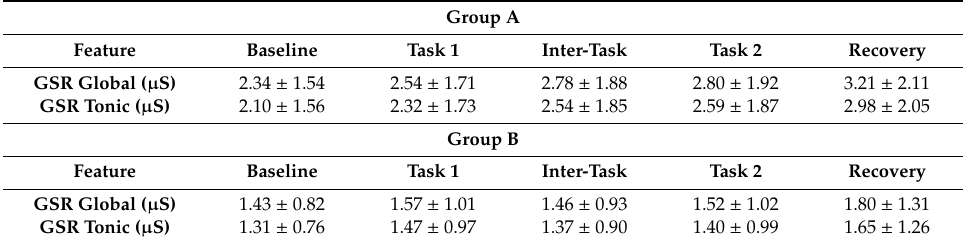
Figure 2. Autonomic parameters variation across the test phases for Group B: global GSR (**: p < 0.01). Table 2. GSR features, expressed as means ± SDs, for the two groups, separately.